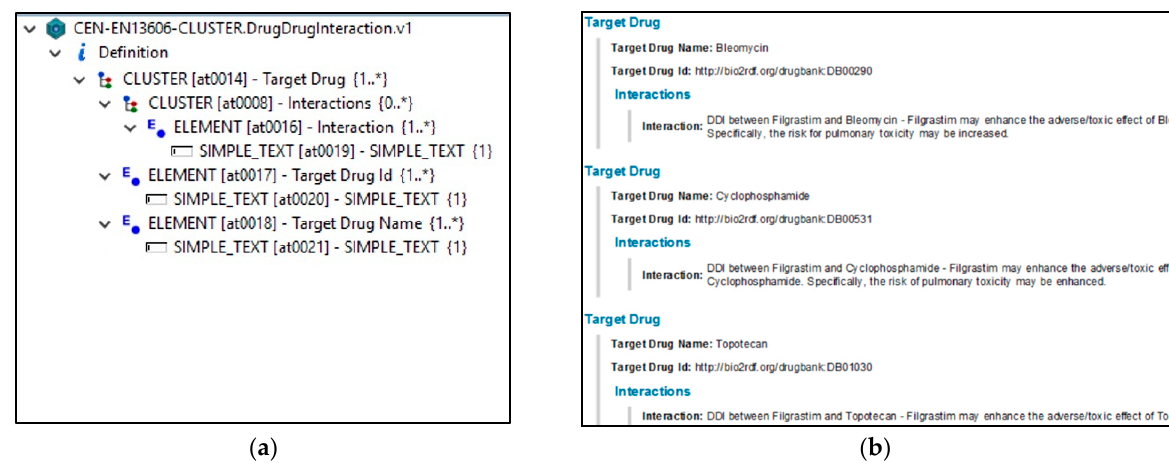
Figure 6. ( a ) A LinkEHR visualization of the augmentation archetype CEN-EN13606-CLUSTER.DrugDrugInteraction.v1 for drug–drug interactions of the example in section D. ( b ) an instance of the CEN-EN13606-CLUSTER.DrugDrugInteraction.v1 augmentation archetype presented in HTML and holding drug–drug interactions for Filgrastim (i.e., the augmentation content resulting from the example in section C).